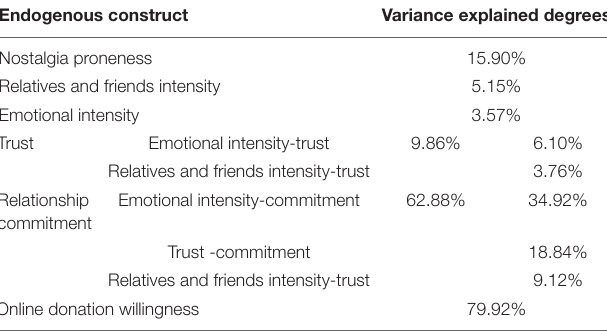
TABLE 5 | Variance explained by endogenous